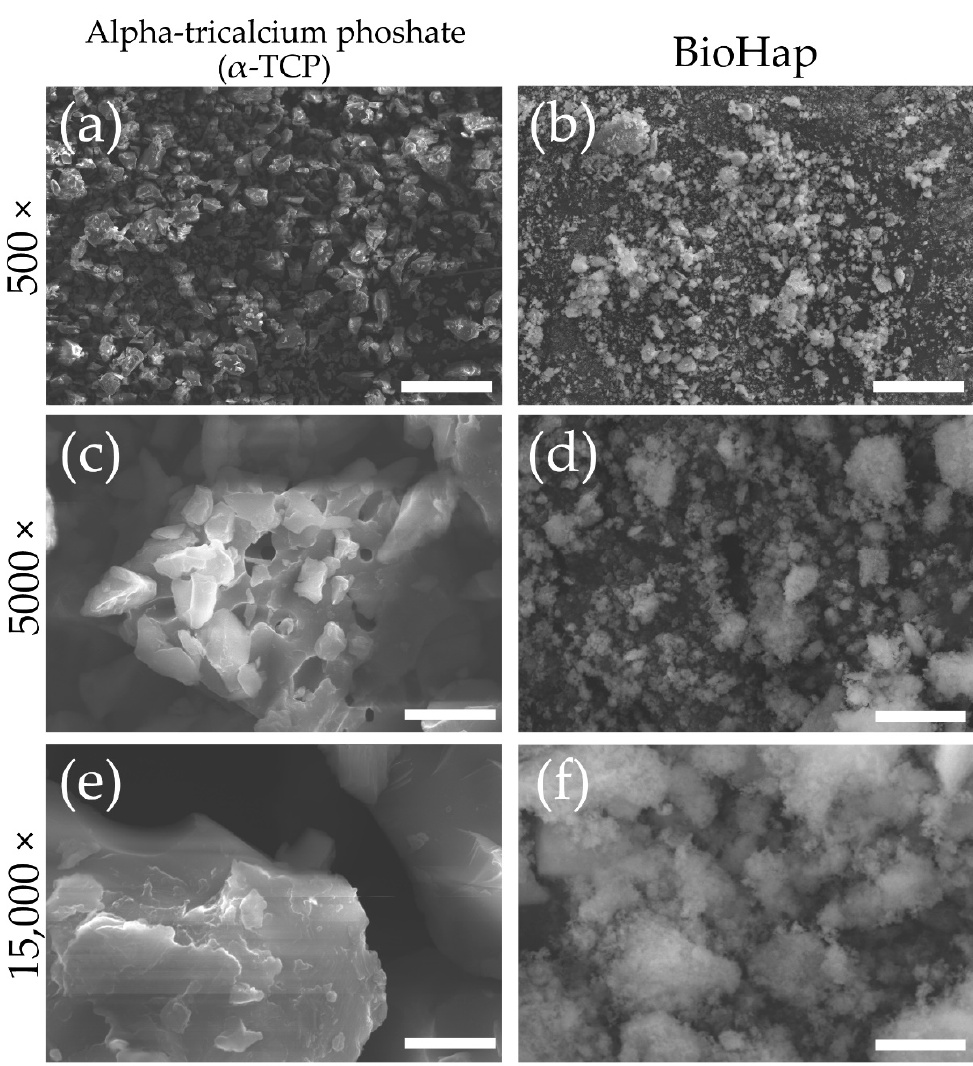
Figure 1. Particle shapes of alpha-tricalcium phoshate ( α -TCP) and BioHap. ( a , c , e ) Scanning electron microscopy (SEM) images of alpha-tricalcium phosphate ( α -TCP) particle carbon deposition sample. ( b , d , f ) SEM images of BioHap particle carbon deposition sample. ( a , b ) Scale bar is 50 µ m (at 500 × magnification). ( c , d ) Scale bar is 5 µ m (at 5000 × magnification). ( e , f ) Scale bar is 1.5 µ m (at 15,000 × magnification).